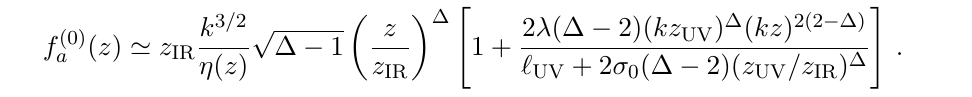
Figure 4 . Same as (cid:12)gure 3, except with g 5 numerically solving the equations of